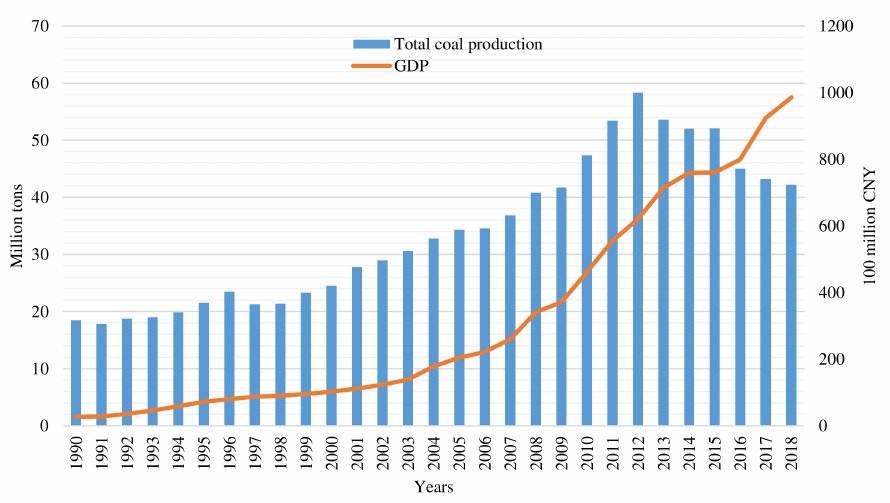
Figure 2. The total coal production and GDP in Huaibei City from 1990 to 2018. Huaibei City’s underground water level is 2–3 m, the annual average temperature is 14.5 ◦ C, and the annual average amount of precipitation is 862.9 mm. As a coal–grain mixed zone in high ground water areas, land use in Huaibei prioritizes agriculture before coal mining development. With the development of coal mining, the coal industry has gradually become the pillar industry in the economic development of Huaibei since the 1990s. After 2010, the city entered a transition period, and the proportion of coal industry output value gradually decreased (Figure 3). With constant large-scale coal mining, the cultivated land is in the process of dynamic subsidence, which further results in waterlog- ging and becomes a water body, increasing the proportion of affected cultivated land. In the future, coal resource mining activities will continue, and their impact on land use will continue to